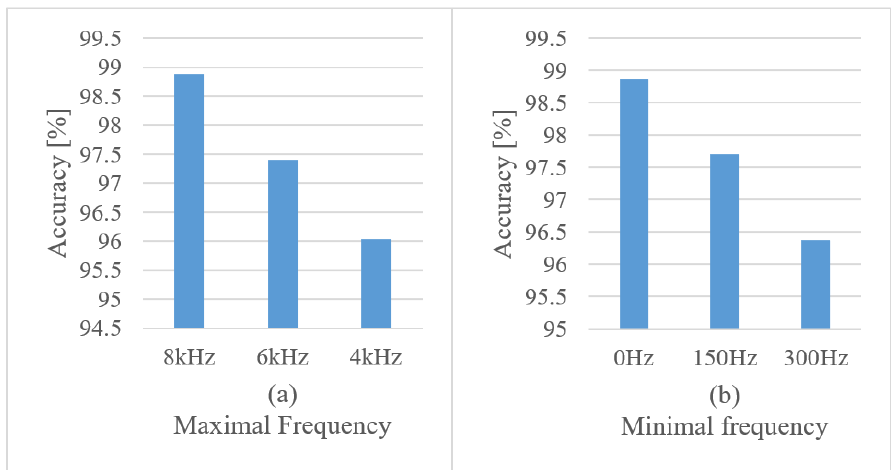
Figure 10. Accuracies for maximal frequency limits with the minimal frequency set to 0 Hz ( a ), and a minimal frequency test with the maximal frequency set to 8 kHz ( b ) using 1 s-long spectrograms.